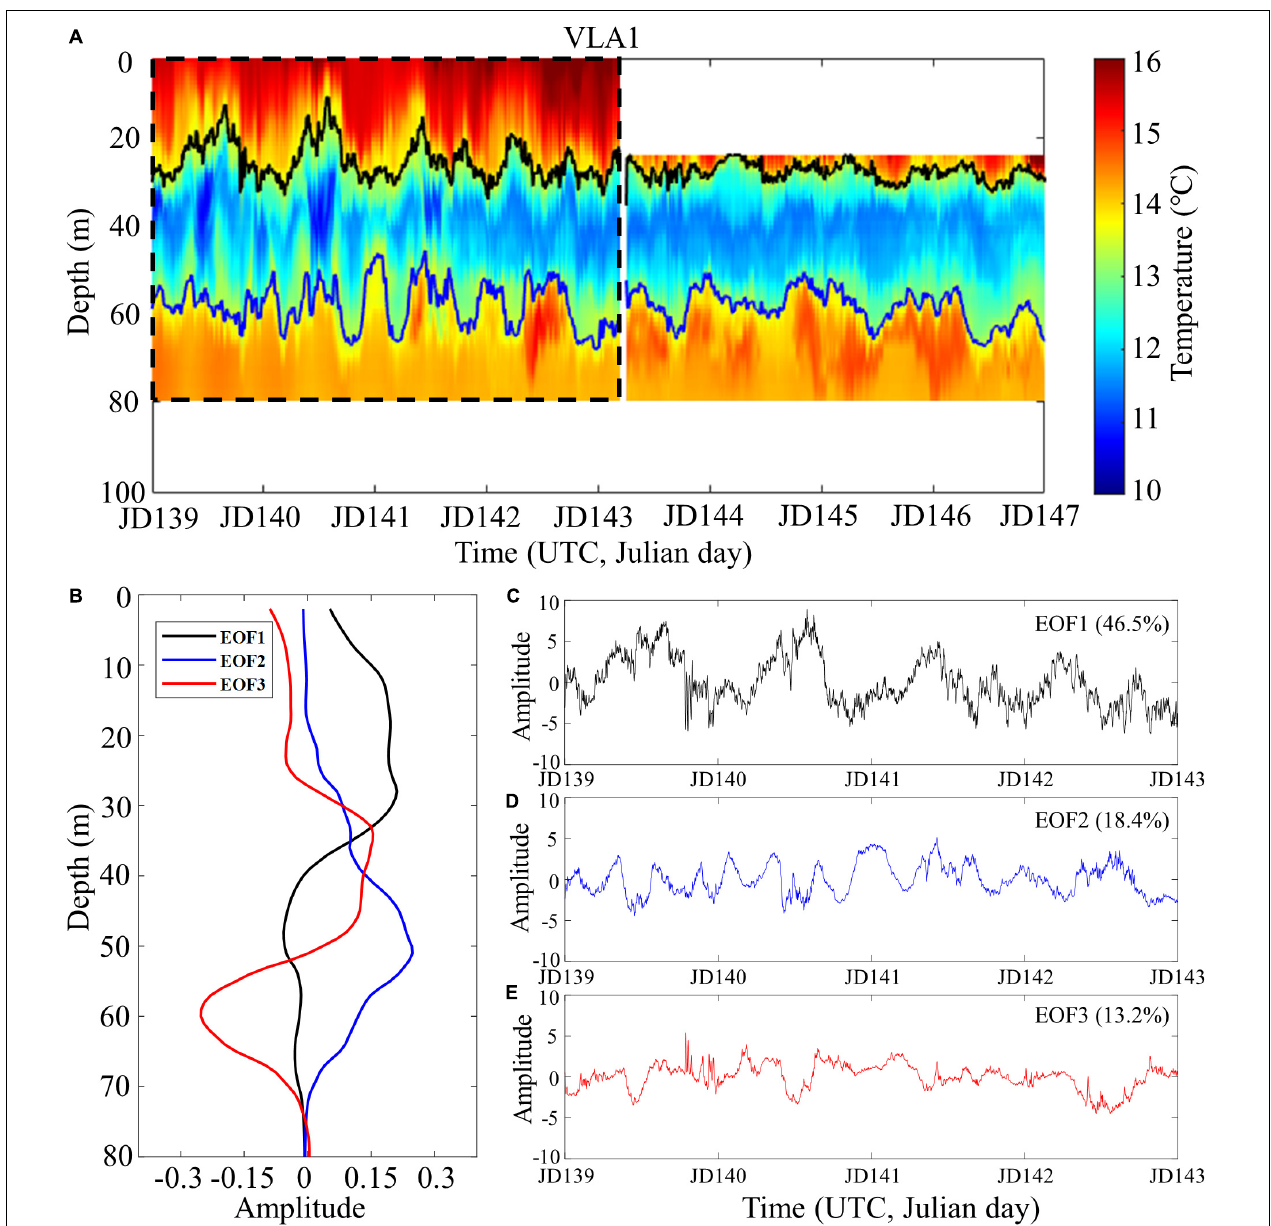
FIGURE 7 | (A) Temporal variation of the temperature profile in the water column measured at VLA1 during the experiment. (B) Amplitude of the first three empirical orthogonal function (EOF) modes for the temperature profiles measured during the first 4 days marked by the dashed box in panel (A) . (C–E) Temporal variations of the first three EOF